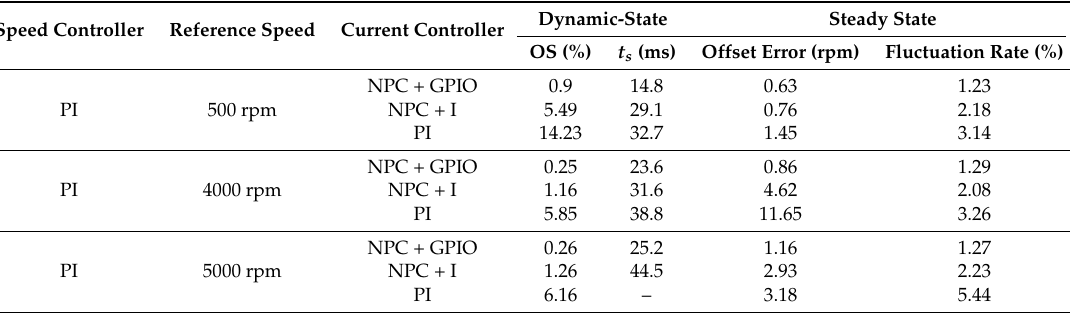
Table 5. Comparison of speed tracking performance